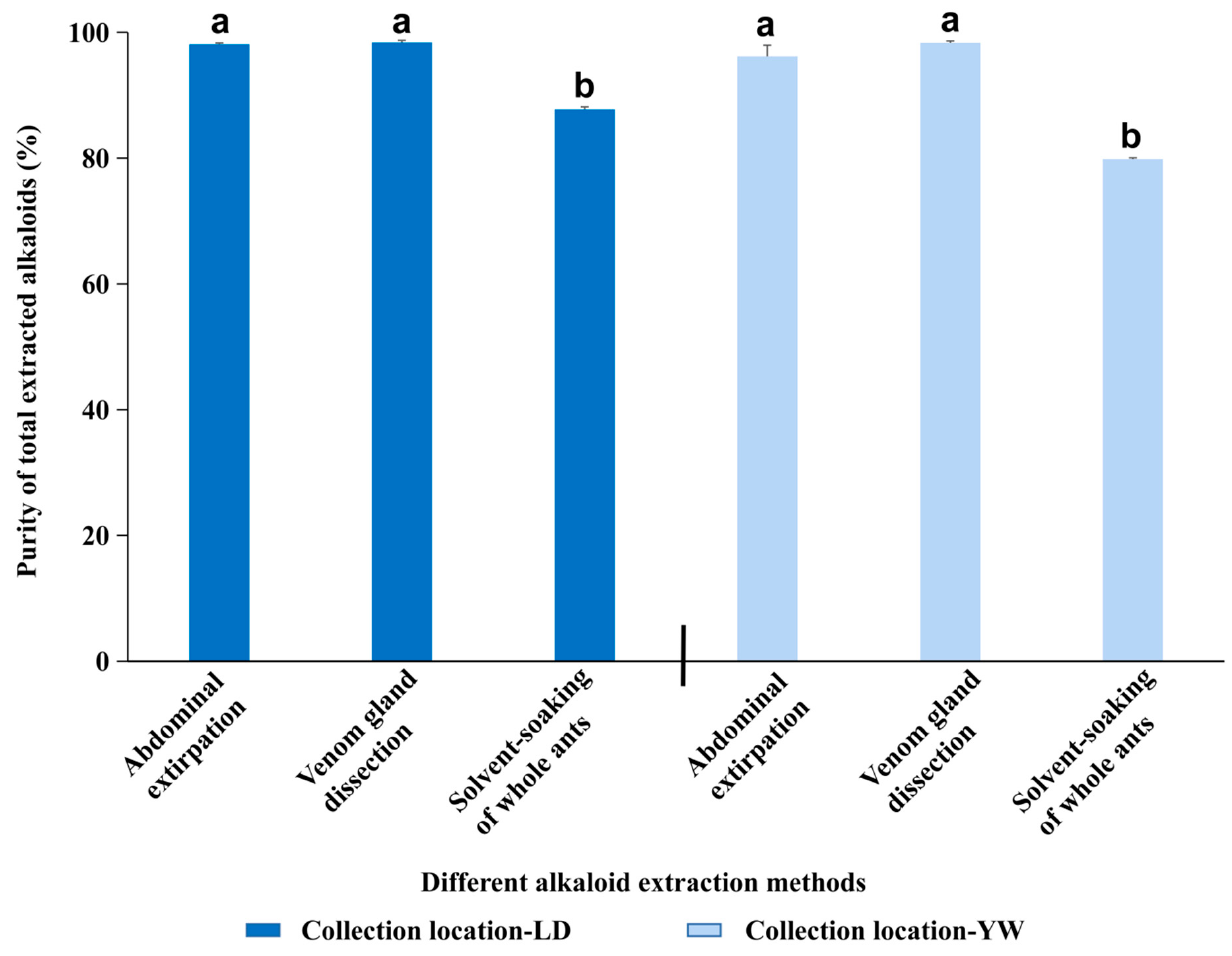
Figure 3. Purity of alkaloids from S. invicta obtained by different extraction methods (abdominal extirpation, venom gland dissection, and whole-body solvent soaking) and from different collection locations. Bars labeled with different lowercase letters are significantly different ( p < 0.05) from each other (different extraction methods) in the same series; all multiple comparisons were performed using Tukey’s HSD test. Values are the means (+SEs) of triplicate experiments. On the 4th and 8th days in the AI and BI groups, epidermal cell necrosis at the site of skin tissue injury, nuclear shrinkage, fragmentation, dissolution, and bilateral spinous layer thickening were observed. The collagen fibers of the dermis and subcutaneous tissues and the myocytes of the hypodermis showed large areas of necrosis, accompanied by numerous lymphocytes and neutrophilic infiltration (Figure 5). On the 4th day in the AI and BI groups, compared with the 8th day, small areas of collagen fibers were reduced at the injury site, and the arrangement was sparse and irregular. The skin structures in the VI and SI groups were clear, and no obvious pathological changes were observed (Figure